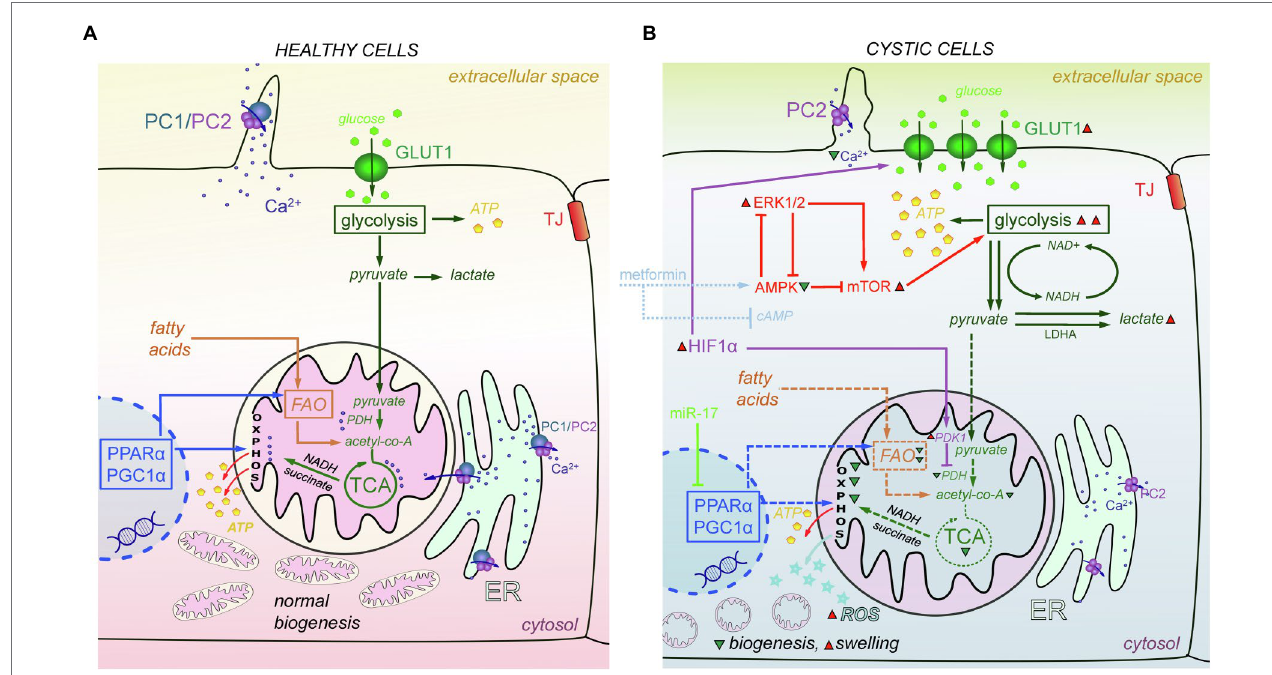
FIGURE 4 | Metabolic and mitochondria-mediated effects in PKD. (A) In mitochondria of the healthy cells, PDH converts pyruvate to acetyl-CoA. Acetyl-CoA is the main fuel for the TCA cycle, which produces NADH and succinate needed for OXPHOS to create ATP molecules. PPAR α and PGC1 α promote energy metabolism by affecting FAO and OXPHOS and help maintain normal mitochondrial biogenesis. PC1/PC2 complexes in cilia and mitochondria-associated membranes of the ER keep Ca 2+ concentration level in range that is sufficient to successfully modulate mitochondrial metabolism, facilitate the work of TCA cycle enzymes, and affect ATP synthase activity. (B) In cystic cells, there is a Warburg shift in ATP production from OXPHOS to glycolysis. Overexpression of HIF-1 α increases the expression of GLUT1, which allows more glucose molecules to pass into the cell. In addition, HIF-1 α affects PDK1 that inhibits PDH and reduces conversion of pyruvate to acetyl-CoA. miR-17 inhibits PPAR α and PGC1 α , which decreases OXPHOS, FAO, and mitochondria biogenesis, and results in ROS production and mitochondrial swelling. In addition, the abnormalities of Ca 2+ transport caused by PC1/PC2 dysfunction also decrease OXPHOS and TCA cycle efficacy, and PDH activity. The AMPK-ERK-mTOR pathway can be targeted to curtail mitochondrial metabolic abnormalities; metformin and other similar drugs can activate AMPK and (independently) suppress cAMP production, which also affects mitochondria. ERK1/2 inhibits AMPK activity and upregulates mTORC1, which then stimulates aerobic glycolysis, increases ATP production, and further inhibits AMPK. Abbreviations: pyruvate dehydrogenase (PDH), oxidative phosphorylation (OXPHOS), affecting fatty acid oxidation (FAO), AMP-activated protein Kinase (AMPK), extracellular signal-regulated kinase (ERK), mammalian target of rapamycin complex 1 (mTORC1), peroxisome proliferator-activated receptor- α (PPAR α ), peroxisome proliferator-activated receptor γ coactivator 1 α (PGC1 α ), reactive oxygen species (ROS), pyruvate dehydrogenase kinase 1 (PDK1), hypoxia-inducible transcription factor-1 α (HIF-1 α ). Green triangles denote a decrease in substance/protein, while red triangles denote an